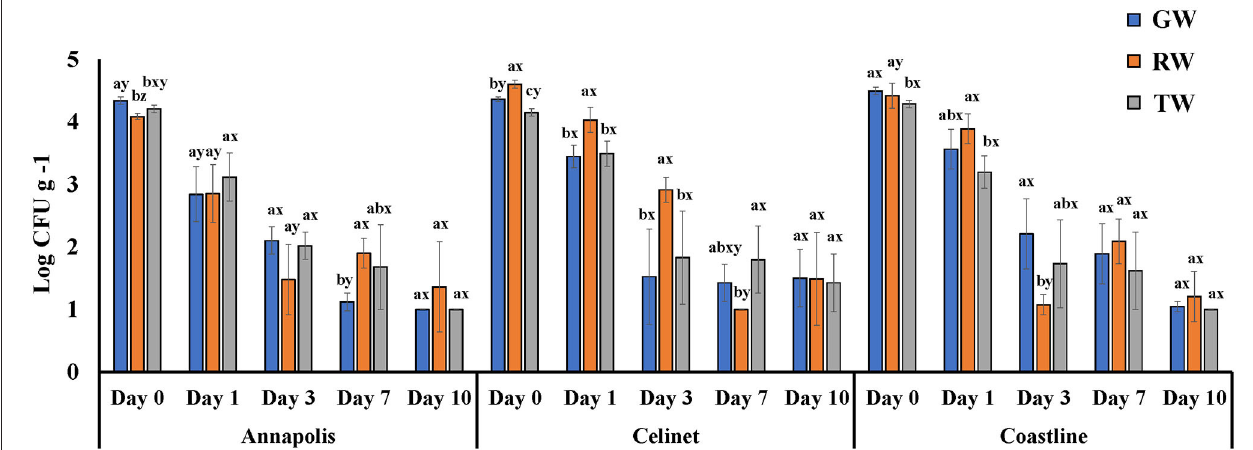
FIGURE 1 | Populations of E. coli O157:H12 recovered from three cultivars of lettuce irrigated with groundwater (GW), roof-collected rain water (RW), and secondary-treated wastewater (TW). Three cultivars included “Annapolis,” “Celinet,” and “Coastline,” and sampling time points were 0, 1, 3, 7, and 10 days post-irrigation. Four replicate samples were analyzed per treatment group at each sampling time point ( n = 4). Error bars indicate the SD. ab Means of bacterial populations in the same sampling time point for the same lettuce cultivar with different letters are significantly different ( P < 0.05). xy Means of bacterial populations in the same time point on different lettuce cultivars irrigated with the same type of irrigation water with different letters are significantly different ( P < 0.05).